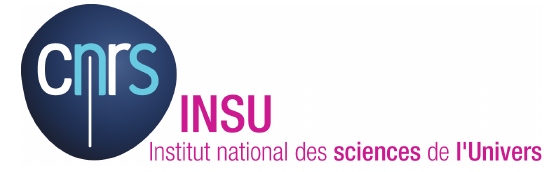
Fig. 6. Mean bias error (MBE), mean absolute error (MAE), root mean square error (RMSE) and box plot for the error distribution in the estimated log H ∗ value with the SPARC-v4.2 method. The whiskers of the box plot show the 5th and 95th percentiles, the box shows the second and third quartile and the red line gives the median value of the